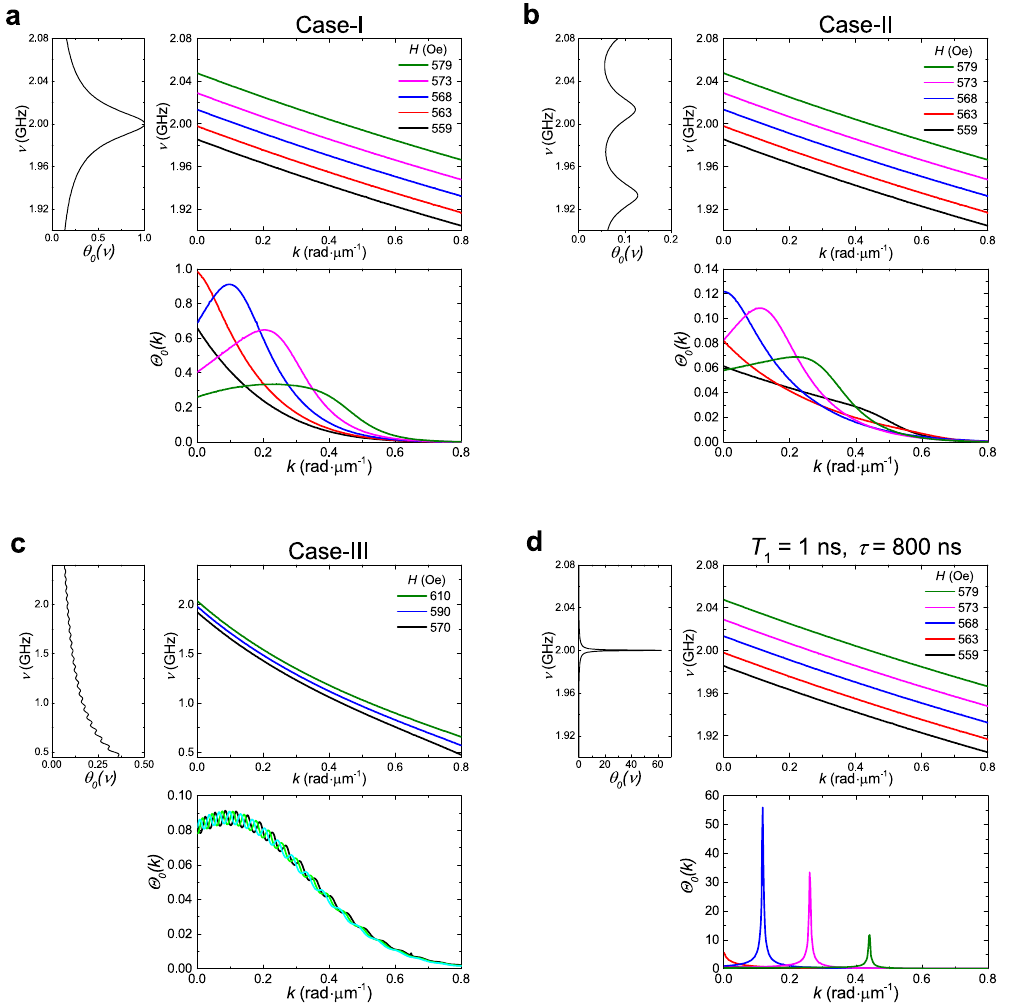
Figure 4. Dependences of the SW amplitude on frequency (upper left panel) and wavenumber (lower panel) for different ratios of the pump-pulse interval and the SW decay time. SWs are generated by the 1GHz-laser in the sample-A ( a ), and by the 80MHz-laser in the sample-A ( b ), and the sample-B ( c ) for different strengths of the external magnetic field. In the upper right panels the SW dispersions are shown. α SW = 5 × 10 − 3 ( a,b ) and = 20 × 10 − 3 ( c ), as found from fitting the experimentally measured dependence of the SW amplitude on the α SW external magnetic field. ( d ) Calculations for the magnetic film with ultra low damping, = . × ( α SW = 1 × 10 − 3